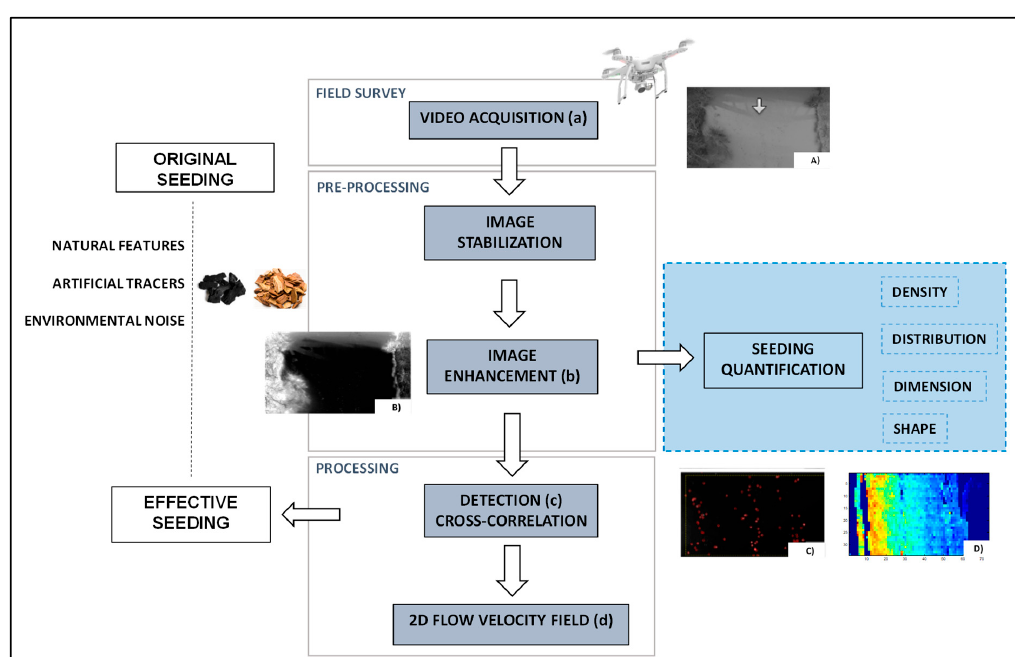
Figure 2. Workflow of surface flow estimation, including seeding quantification and optical methods: ( A ) video acquisition; ( B ) image enhancement; ( C ) feature detection; ( D ) 2D flow velocity field.